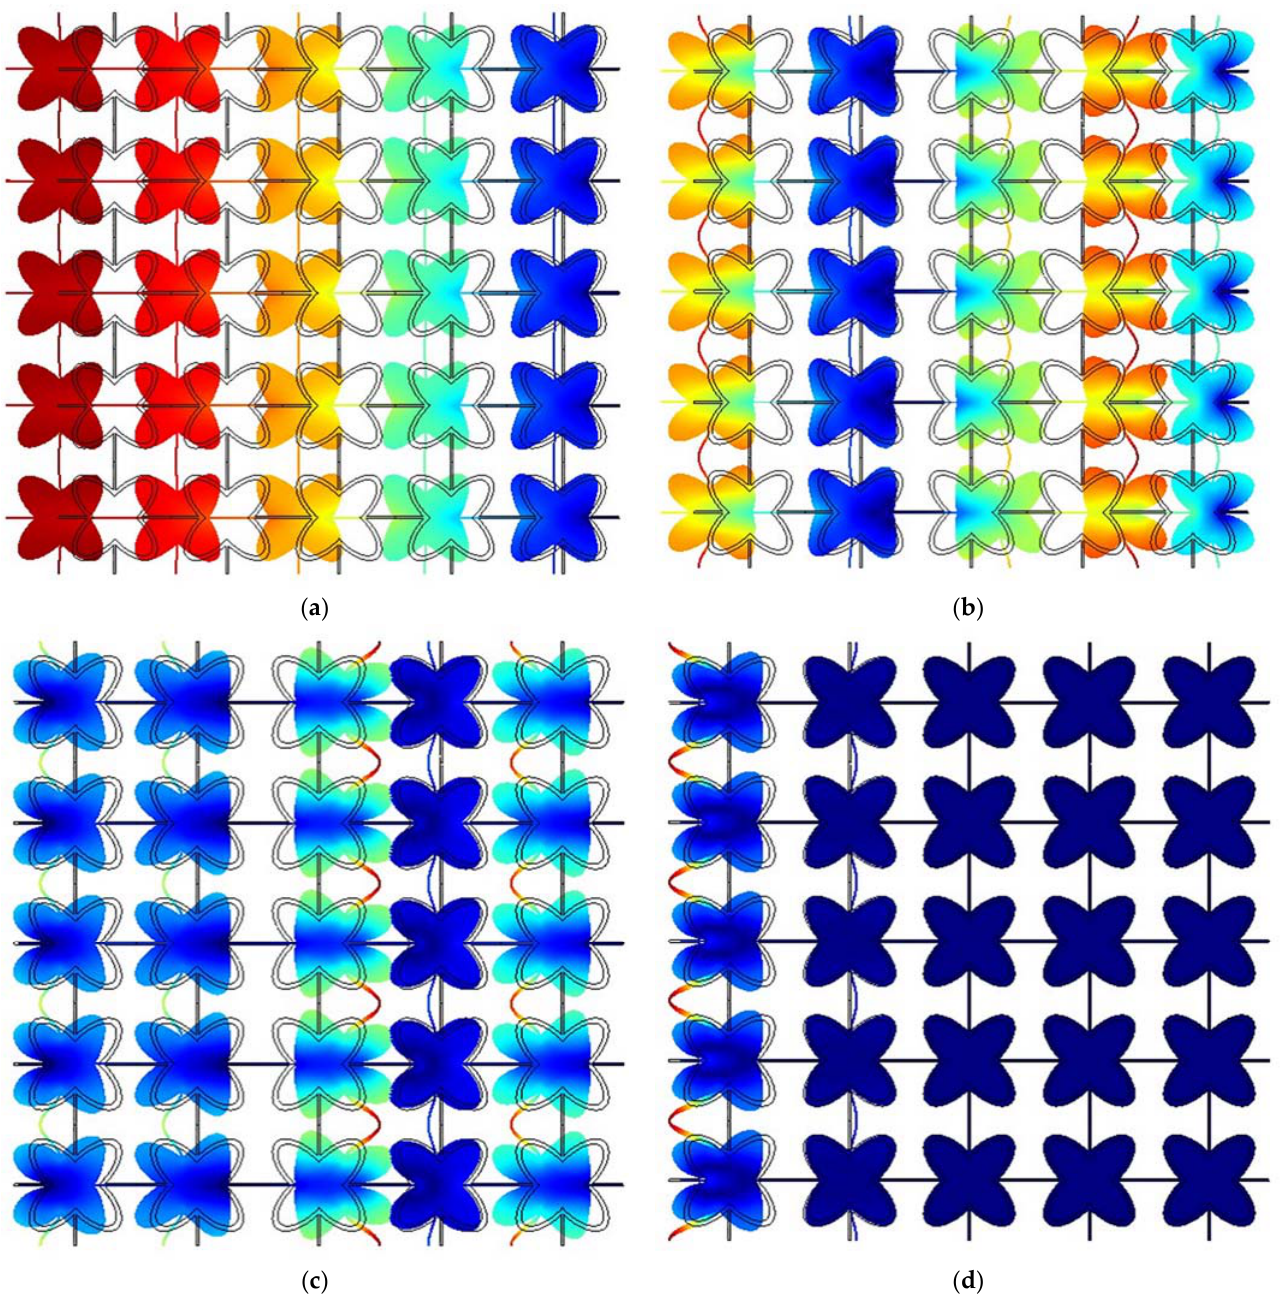
Figure 17. Mesh response at ( a ) 200 Hz, ( b ) 550 Hz, ( c ) 875 Hz and ( d ) 1100 Hz.